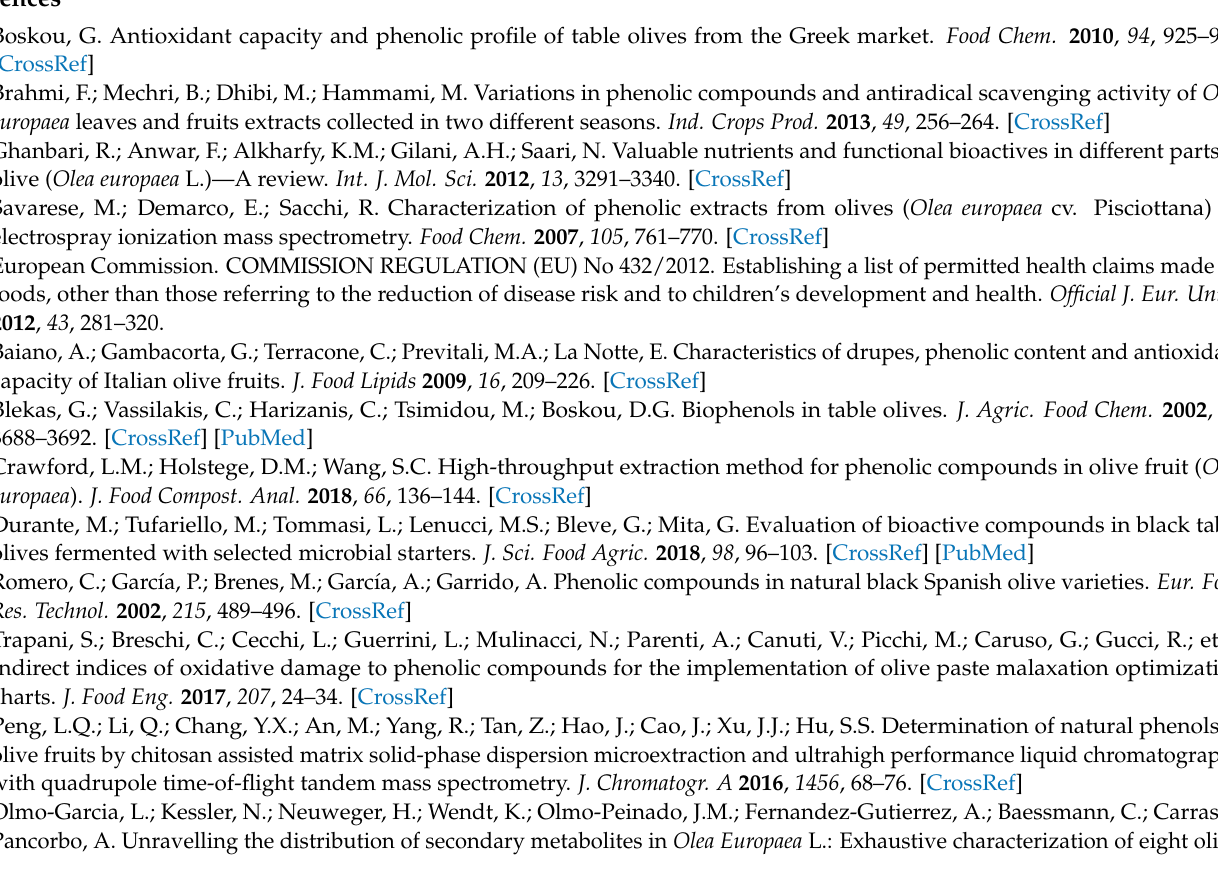
Table S4. Evaluation of linearity, repeatability, intermediate precision, trueness and selectivity for the determination of phenolic compounds in olive fruits, Table S5. Target list of phenolic compounds, Table S6. Suspect list of bioactive compounds encountered in olive samples, Table S7. Maturation stage of Kolovi samples, Table S8. LC gradient elution and flow rate program